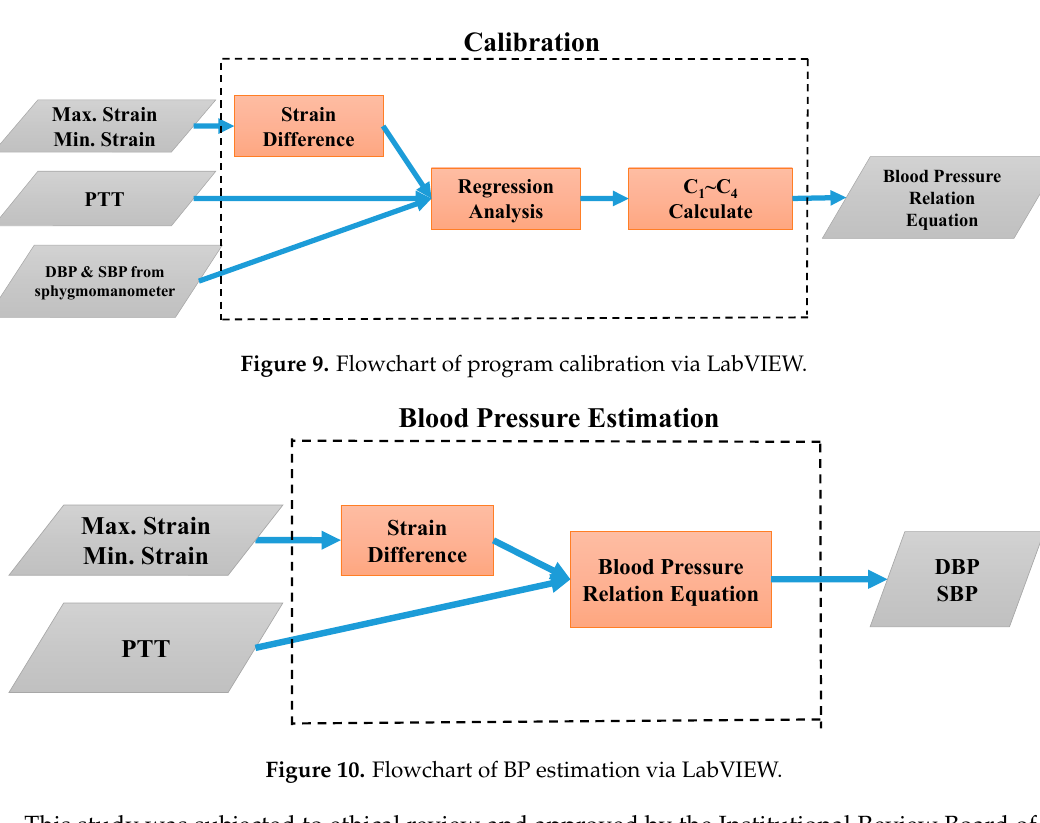
Figure 10. Flowchart of BP estimation via LabVIEW.